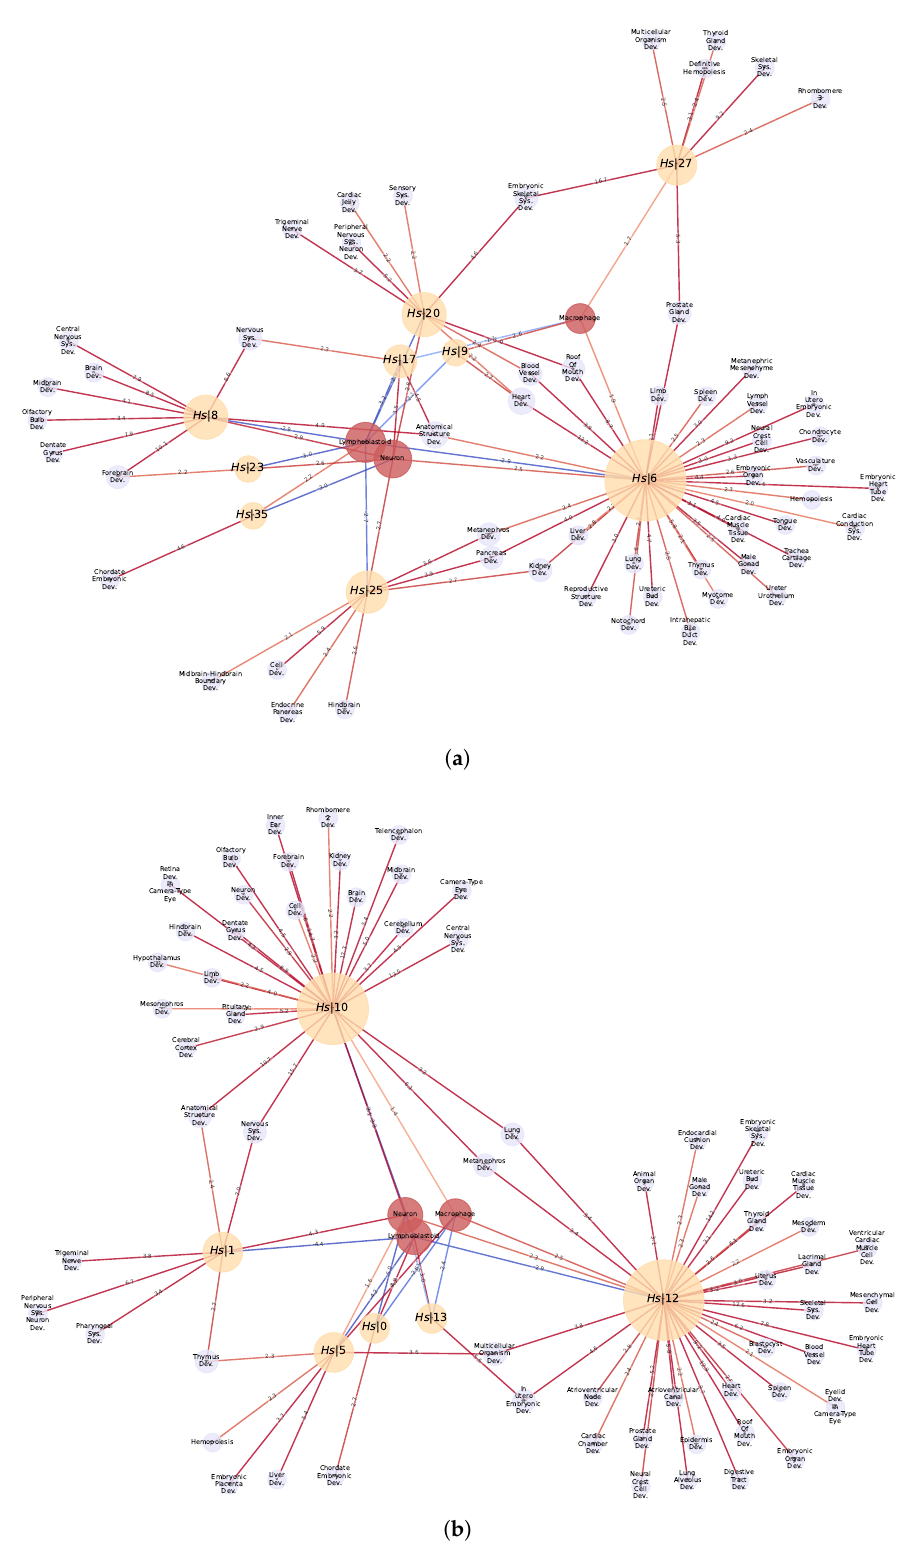
EmbryonicHeartTubeDev. TongueDev.EmbryonicOrganDev.